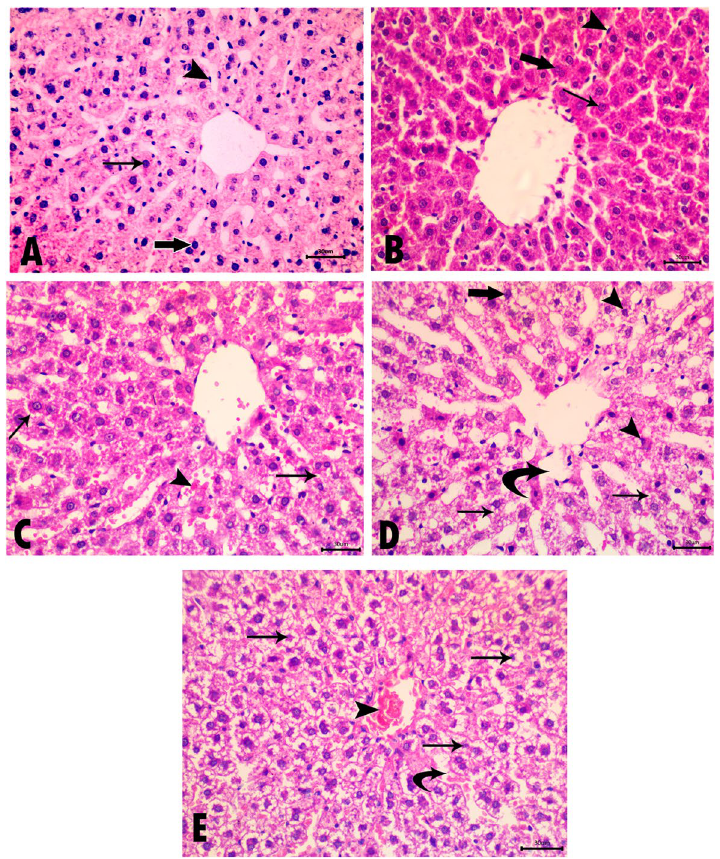
Fig. 7 Photomicrographs of sections in the liver stained with H&E ( 400). A and B Negative and positive control groups show a normal × architecture of tightly packed cords of hepatocytes around the central vein and blood sinusoid in between. Polyhedral hepatocytes with acidophilic cytoplasm and rounded vesicular nuclei with prominent nucleoli are seen (arrow). Some binucleated cells are also existing (thick arrow). Blood sinusoids are lined by flattened endothelial cells (arrowhead). C Acute treated group reveals dilated congested blood sinusoids (arrowhead), and most of the hepatocytes appear with vacuolated cytoplasm (arrows). D Chronic treated group showing disturbed liver architecture with dilated blood sinusoids (curved arrow). Hepatocytes appear with vacuolated cytoplasm (arrows); some have degenerated nuclei (arrowheads), and others have irregularly shaped nuclei (thick arrow). E Chronic withdrawal group reveals degenerated hepatocytes. Liver cells appear with multiple large, coalesced vacuoles and degenerated nuclei (arrows). Congested central vein (arrowhead) and dilated congested blood sinusoid (curved arrow) are also